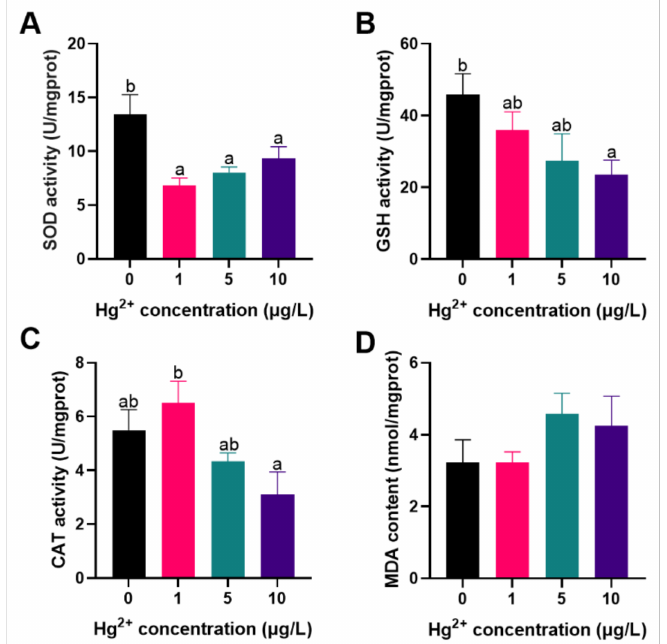
Figure 1. Response to the antioxidant ability of silver carp larvae exposed to Hg 2+ . ( A ) SOD activity; ( B ) GSH activity; ( C ) CAT activity; ( D ) MDA content. Vertical bars represent the mean ± SE ( n = 3). Different letters indicate significant differences between groups ( p <